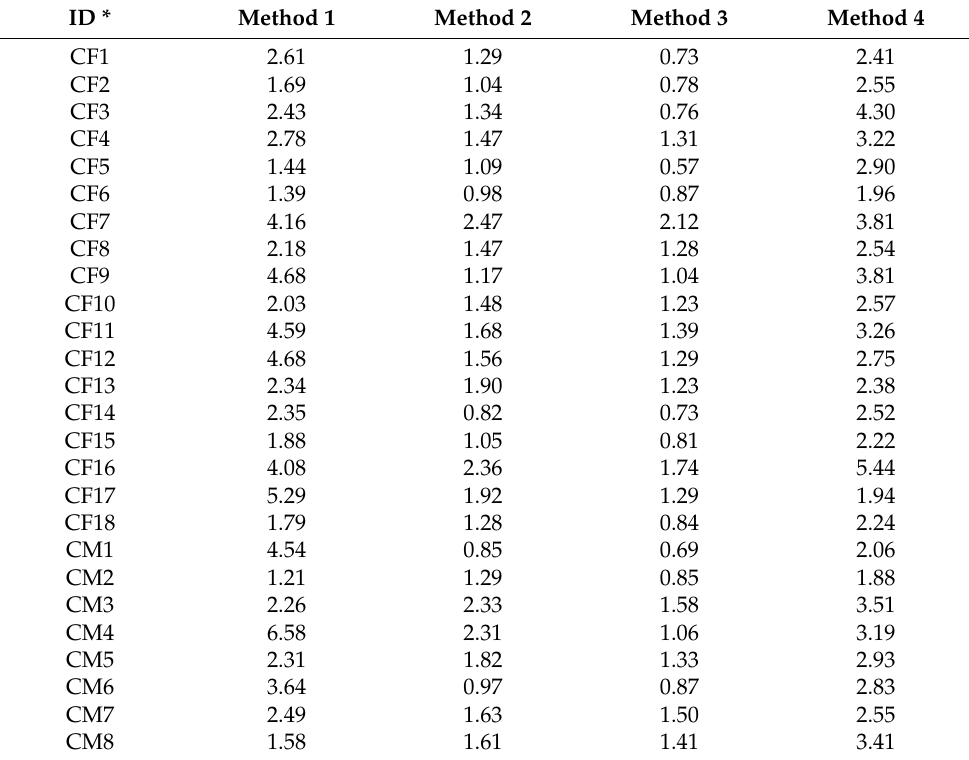
Table A2. Error of the four Ps estimation methods for each vocally typical participant in terms of root-mean-square error (units of cm H 2 O) with respect to reference Ps values measured using the indirect intraoral equilibration method.